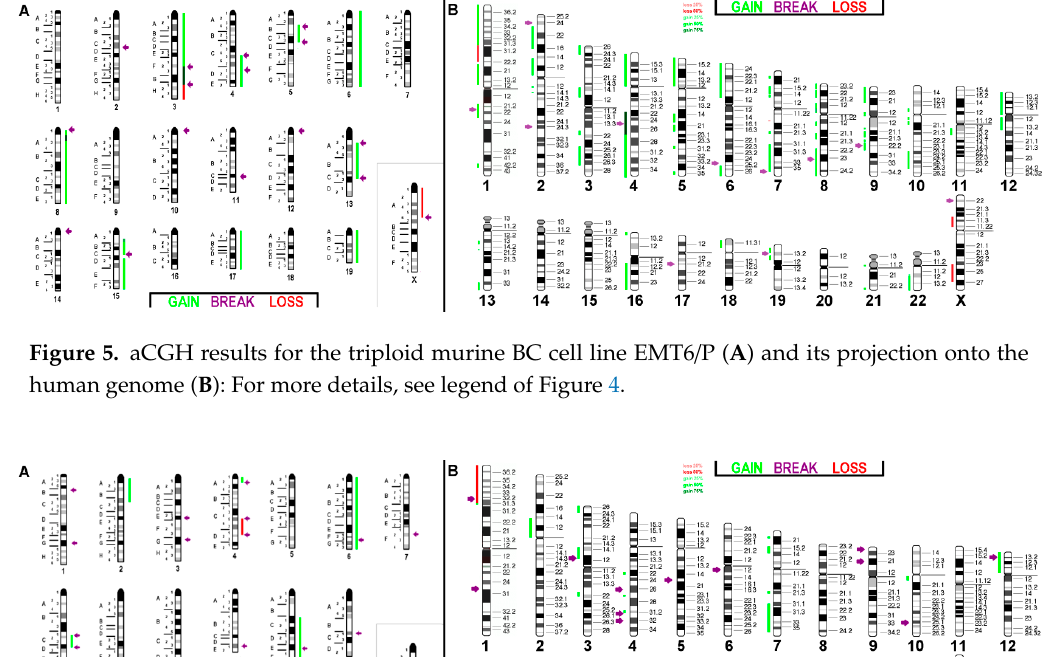
Figure 6. aCGH results for near diploid murine BC cell line TA3 Hauschka ( A ) and its projection onto the human genome ( B ): For more details, see legend of Figure 4.